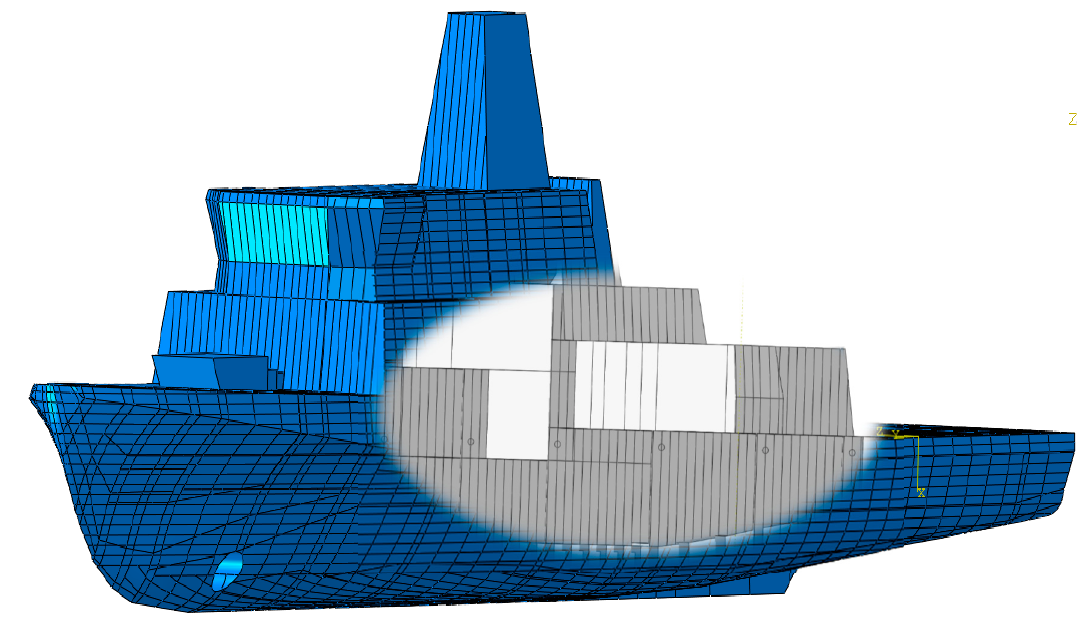
Figure 6. Modern minehunter geometry with random cabin layout.